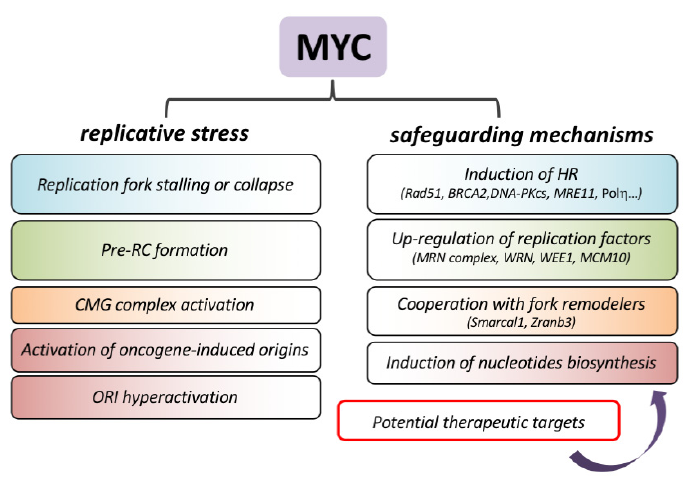
Figure 3. Overview of potential sources of MYC-induced replicative stress (on the left) and of processes that render replication stress latent in MYC-overexpressing cells (on the right). As argued in the text, these processes represent an attractive liability of MYC-driven cancers that could be exploited therapeutically.